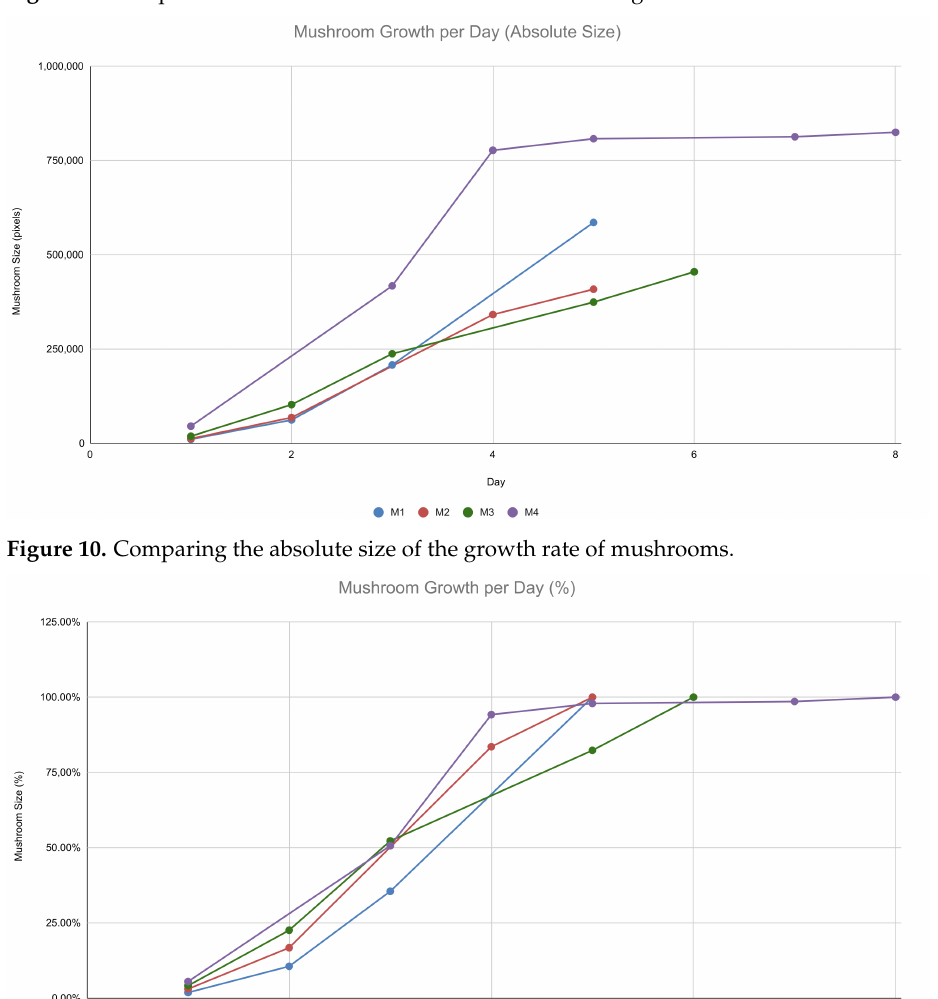
Figure 9. Example of mushroom detection in three different stages.